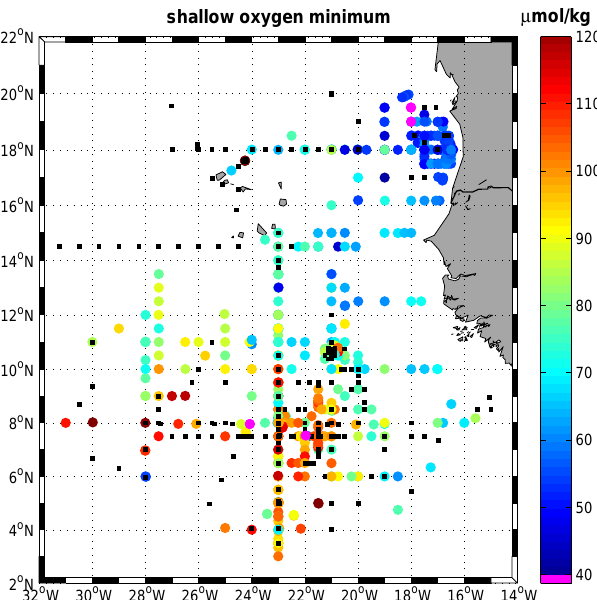
Figure 4. Minimum oxygen concentration above 200m (represent- ing the shallow oxygen minimum) as obtained from CTD station data taken during the period 2006–2013. Black squares indicate pro- files without a shallow oxygen minimum (i.e. the minimum oxygen concentration was found at the lower boundary of the chosen depth range, that is 200m). Oxygen concentration at the shallow oxygen minimum below 40µmolkg − 1 is marked by purple dots.